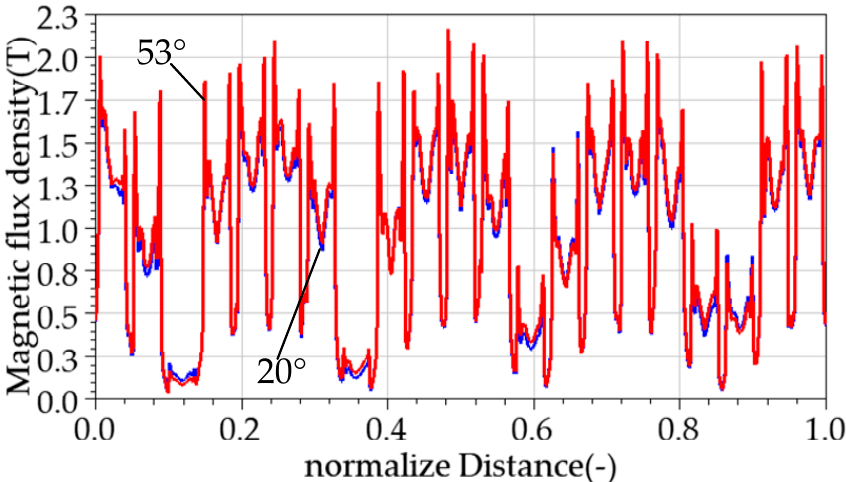
Figure 16. Air gap magnetic flux density at different temperatures.